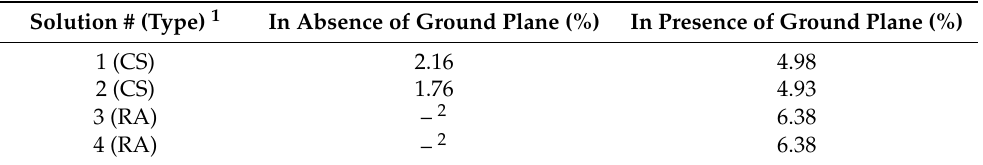
Table 3. Maximum rate of change among the elements of the resonant linear array structure in comparison with the half-wavelength design for the Complex Pattern Case